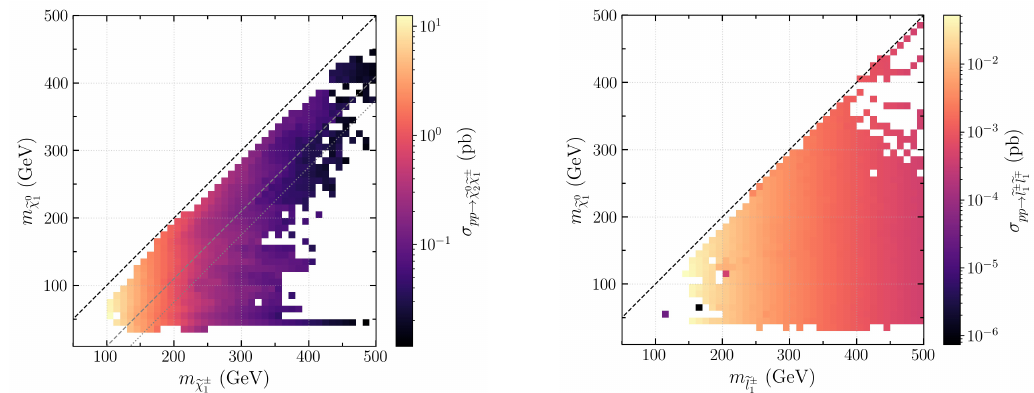
Figure 5: The mass of the DM particle versus the mass of the lightest chargino (left) and smuon (right), combined in 10 by 10 GeV bins. The average production cross sec- tion of σ (left) and σ χ ± pp → (cid:101) χ 0 2 (cid:101) 1 dashed black line in the plot on the left-hand side shows the limit where m whereas the gray dashed (dotted) lines show m The dashed black line in the plot on the right-hand side shows m